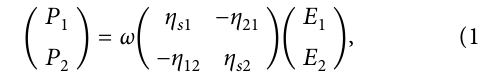
Figure 2: SEA model of two